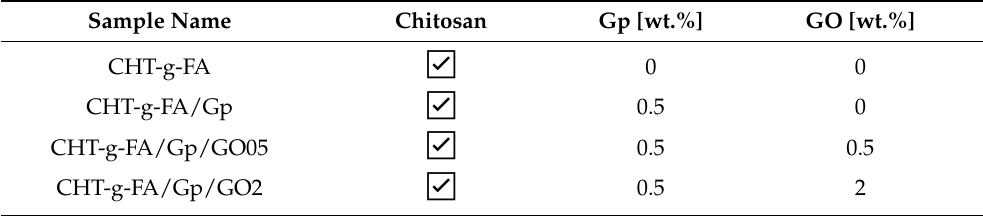
Table 2. Modified CHT-based materials. Gp and GO percentages concern the polymer mass.